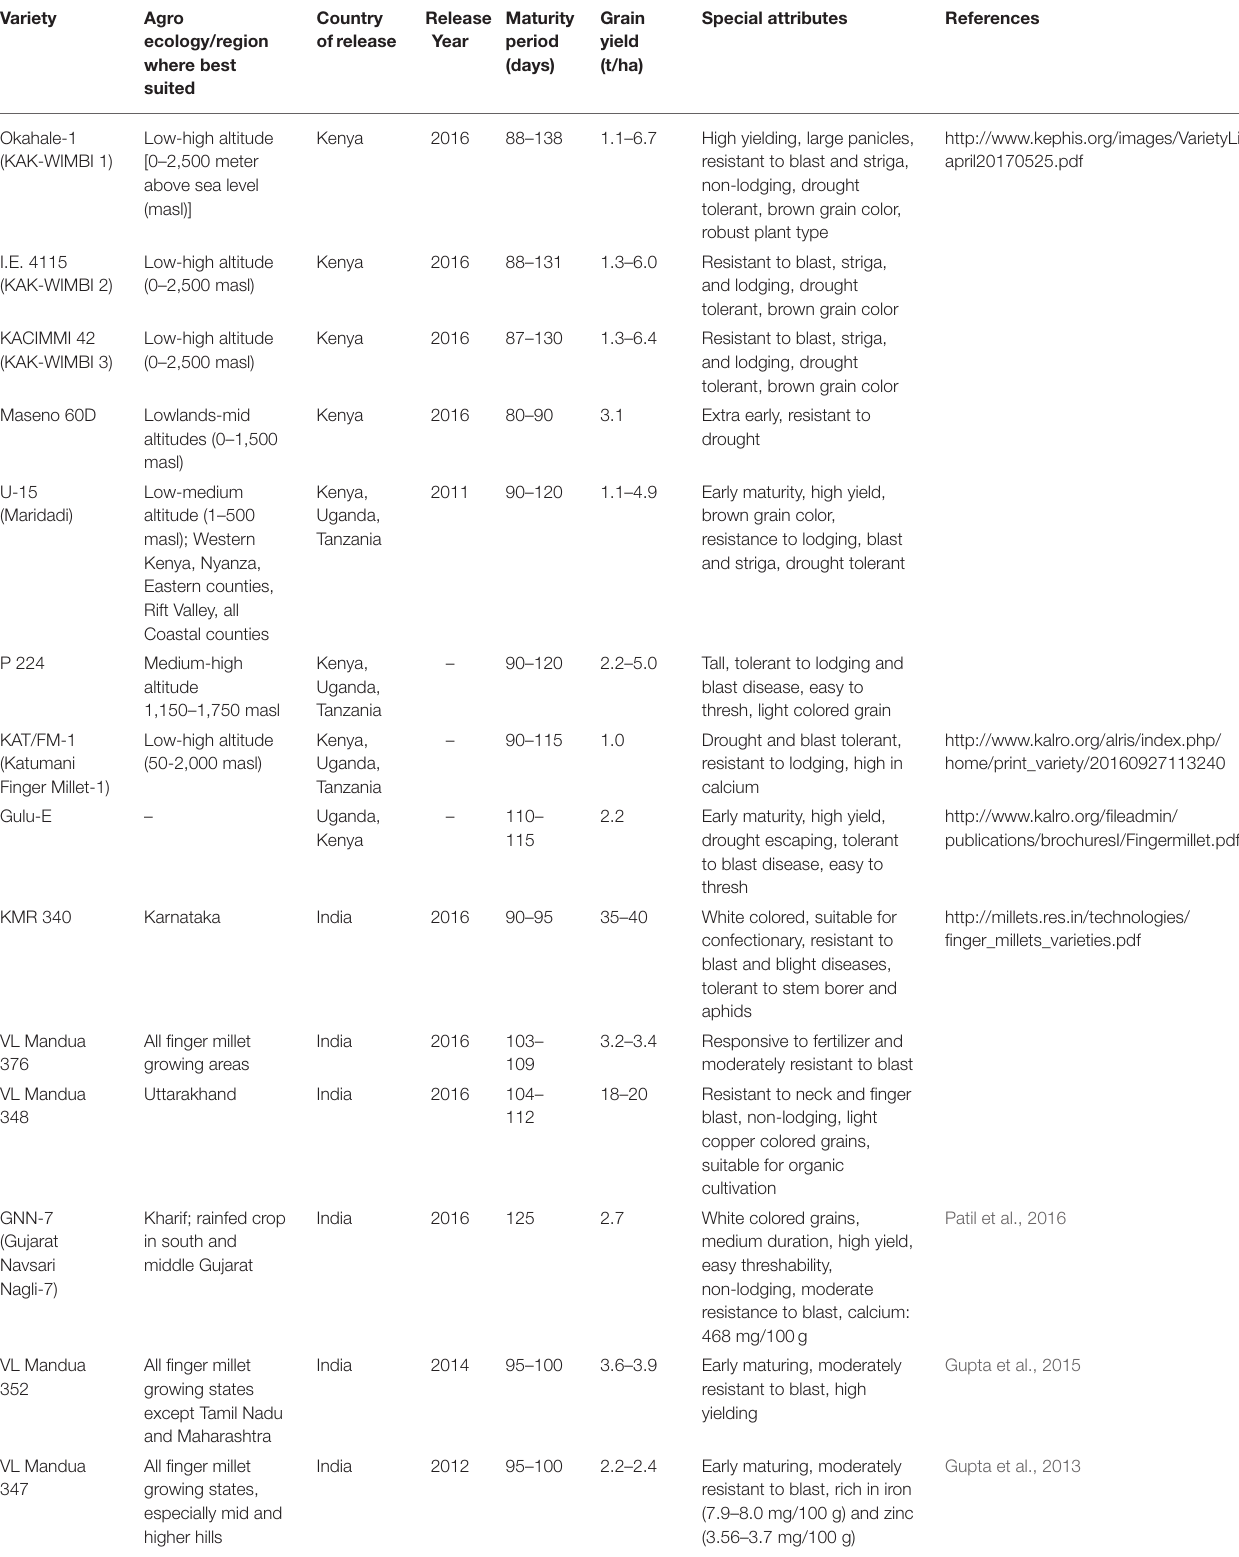
TABLE 2 | Modern finger millet varieties released in the last decade.